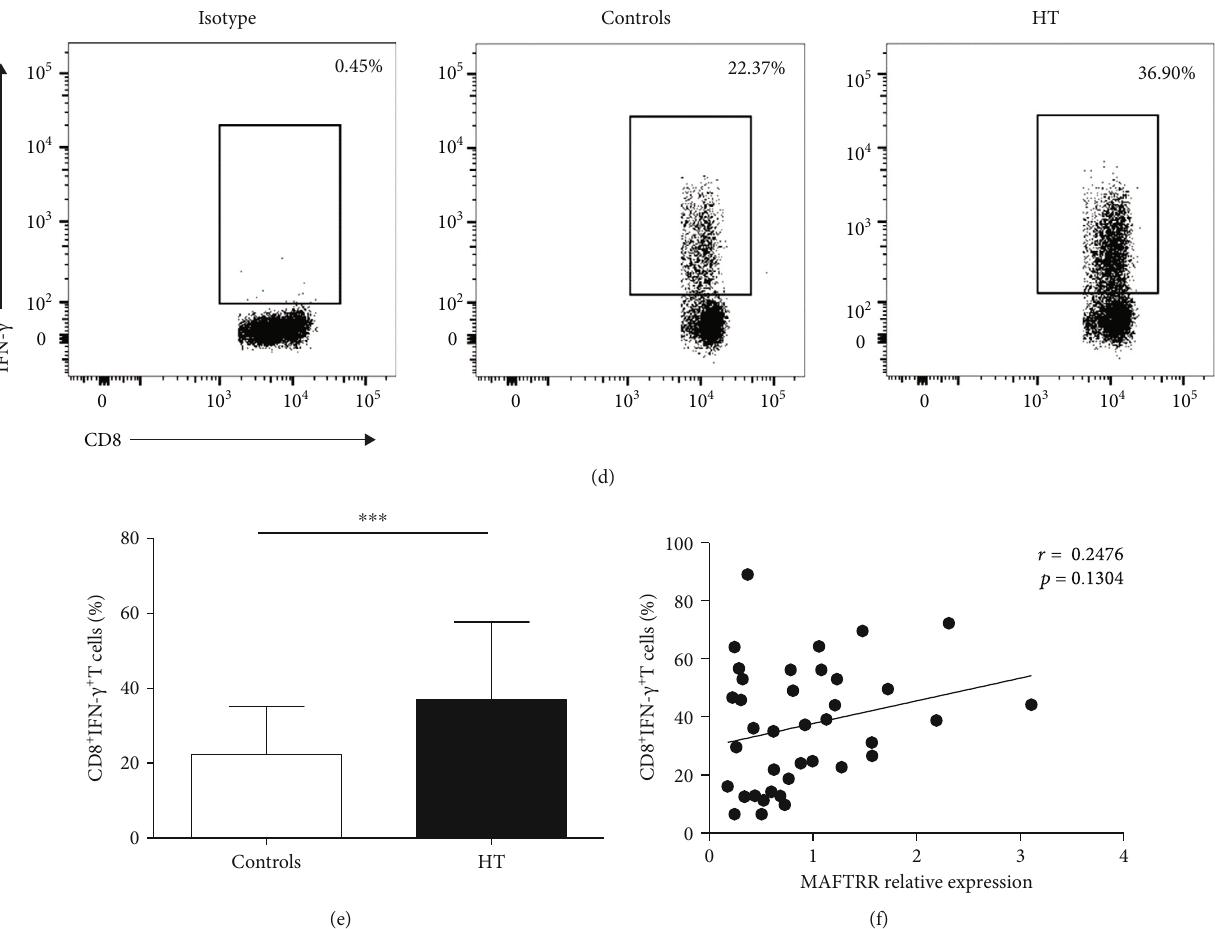
Figure 3: Positive correlation between MAFTRR expression and circulating Th1 cells in the HT patients. Fresh peripheral blood was collected, and the PBMCs were subsequently separated from peripheral blood within four hours and analyzed the proportion of Th1 cells by fl ow cytometry analysis. (a) Representative fl ow cytometry dot plots of Th1 cells are indicated. Values in the upper left rectangular region correspond to the proportion of Th1 cells. (b) The proportion of Th1 cells is shown in the peripheral blood from the HT patients and controls. (c) The correlation between the transcript levels of MAFTRR and the percentages of Th1 cells is shown in the peripheral blood from the HT patients. (d) Values in the upper right rectangular region correspond to the proportion of CD8 + IFN- γ + T cells. (e) The percentages of CD8 + IFN- γ + T cells are indicated in the peripheral blood from the HT patients and controls. (f) The correlation between the transcript levels of MAFTRR and the percentages of CD8 + IFN- γ + T cells is shown in the peripheral blood from the HT patients. Each data point represents an individual subject, and the horizontal lines show the mean. ∗∗∗ p < 0 : 001